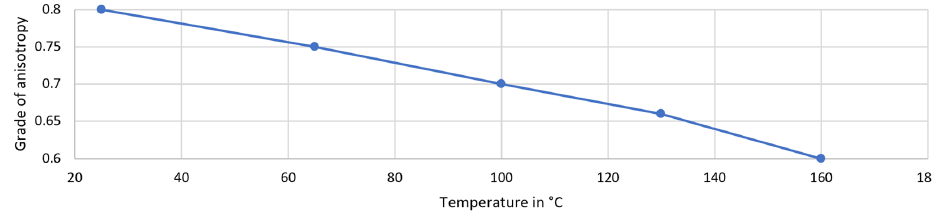
Figure 5. Influence of temperature on anisotropy.